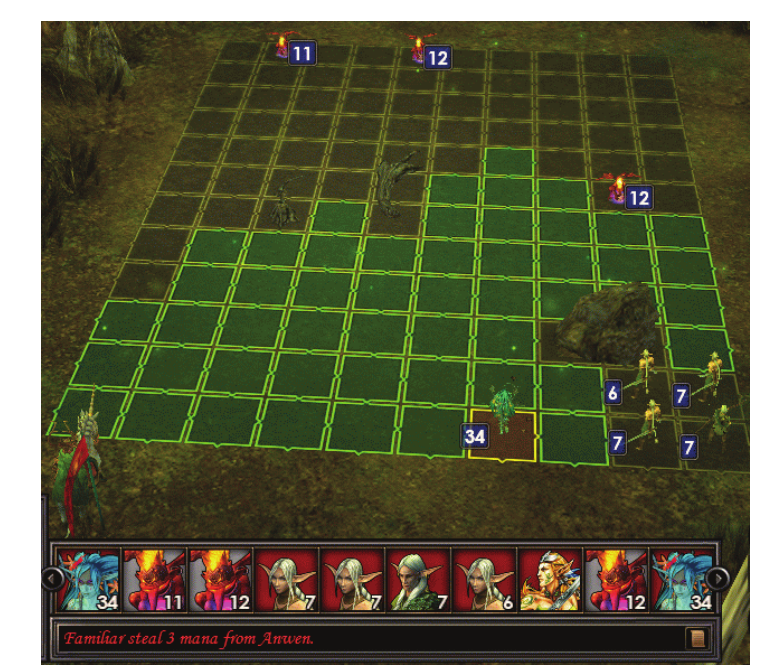
Figure 2: SLG game “Heroes of Might &